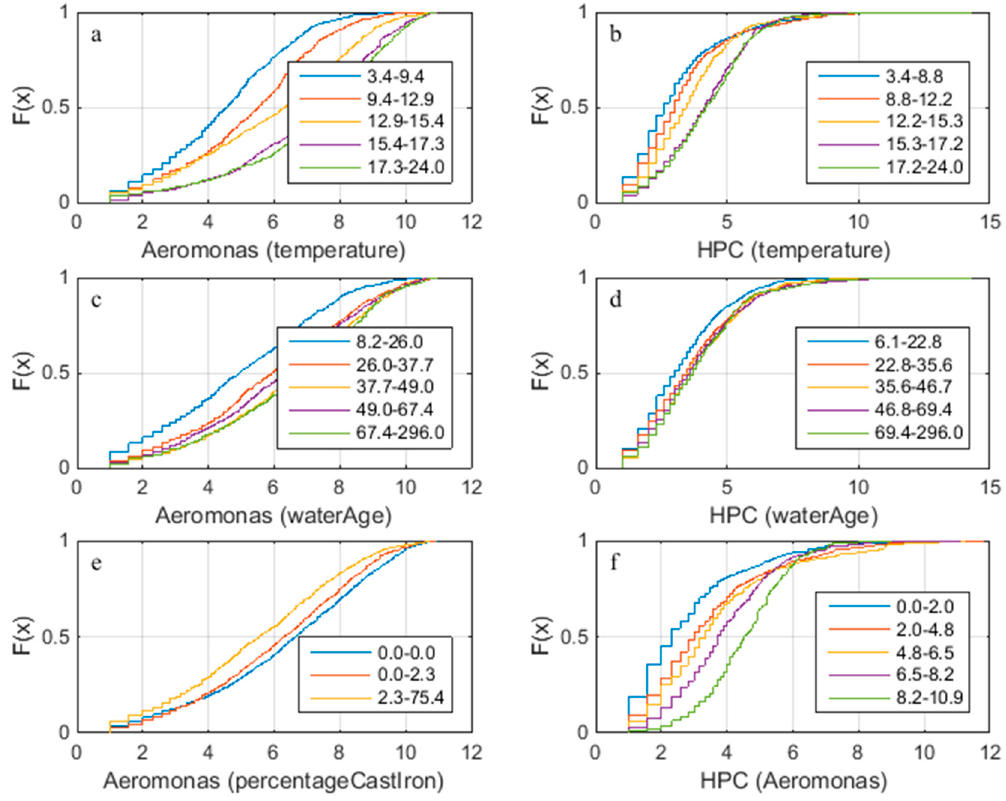
Figure 2. Cumulative frequency distribution for sorted groups ( a ) 2 log( Aeromonas ) sorted by temperature (5 groups, n = 978); ( b ) 2 log( Aeromonas ) sorted by water age (5 groups, n = 976); ( c ) 2 log( Aeromonas ) sorted by percentage Cast Iron (3 groups, n = 1616); ( d ) 2 log(HPC) sorted by temperature (5 groups, n = 1279); ( e ) 2 log(HPC) sorted by water age (5 groups, n = 1277); ( f ) 2 log(HPC) sorted by Aeromonas (5 groups, n = 585).